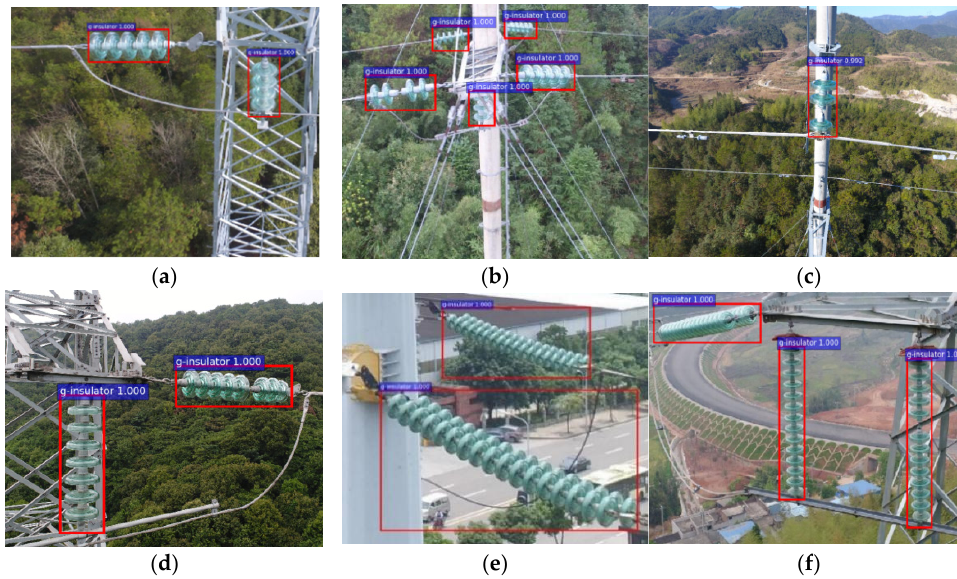
Figure 11. Insulator target detection result: ( a – c ) are the detection in 35kV Transmission line, ( d ) is the detection in 110kV, ( e , f ) is the detection in 220kV.